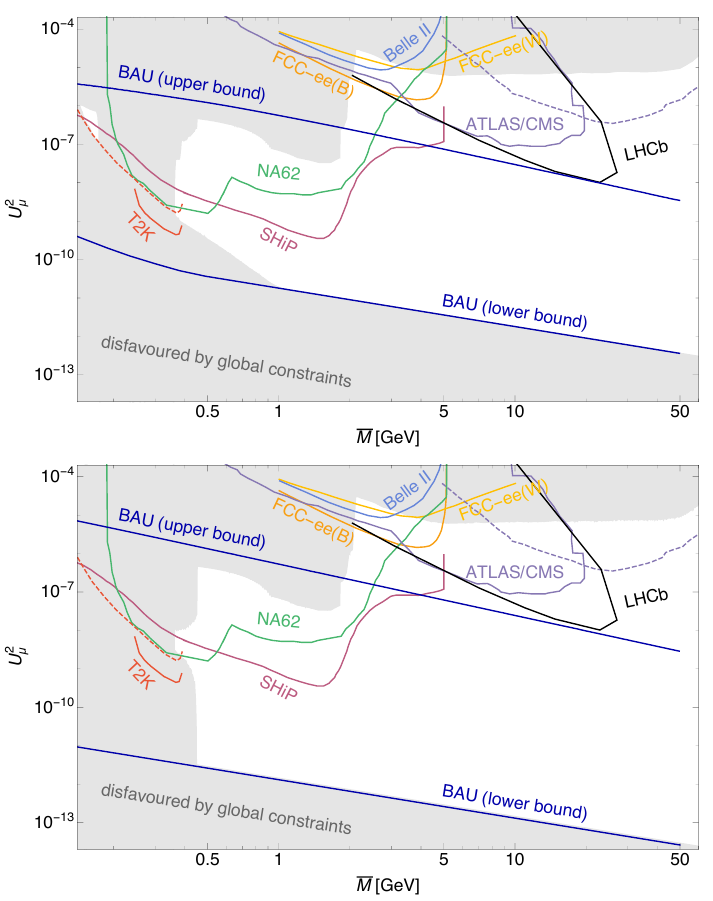
Figure 6 . Limits on U 2 as a function of (cid:22) M = ( M 1 + M 2 ) = 2 for normal hierarchy (top panel) (cid:22) and inverted hierarchy (bottom panel). The grey area corresponds to the parameter region that is disfavoured by the combined constraints discussed in subsection 2.3. The dark blue lines are the upper and lower bound of U 2 consistent with neutrino oscillation data and the requirement to (cid:22) account for the observed BAU. These are compared to the sensitivity of future experiments: the SHiP lines (purple) show the 90% c.l. upper limits assuming 0 : 1 background events in 2 (cid:2) 10 20 proton target collisions for a ratio of U 2 : U 2 : U 2 (cid:24) 1 : 16 : 3 : 8 [166, 167]. The NA62 line e (cid:22) (cid:28) (turquoise) is the expected limit of the NA62 experiment on U 2 with 2 (cid:2) 10 18 400 GeV protons on (cid:22) target [172]. The T2K sensitivity (red) has been estimated in ref. [171] for 10 21 protons on target at 90% c.l. with full volume for both the K + ! (cid:22) + N ! (cid:22) + (cid:22) (cid:0) (cid:25) + two-body decays (red, solid) and the K + ! (cid:22) + N ! (cid:22) + (cid:22) (cid:0) e + (cid:23) e three-body decays (red, dashed) [171]. Limits on U 2 can be (cid:22) obtained from LNV decays of 5 (cid:2) 10 10 B + mesons at Belle II (blue) and 2 (cid:2) 10 8 W bosons (yellow) at the FCC-ee [173]. Similarly, the expected sensitivity from B meson decay at the FCC-ee is given p and prompt trilepton (dashed) searches for s = 13 TeV and 300 fb (cid:0) 1 at ATLAS or CMS